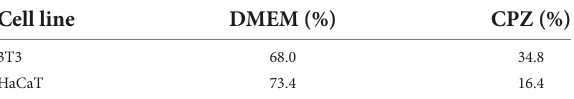
TABLE 4 Comparison of cell viability of irradiated with non-irradiate controls a . Cell